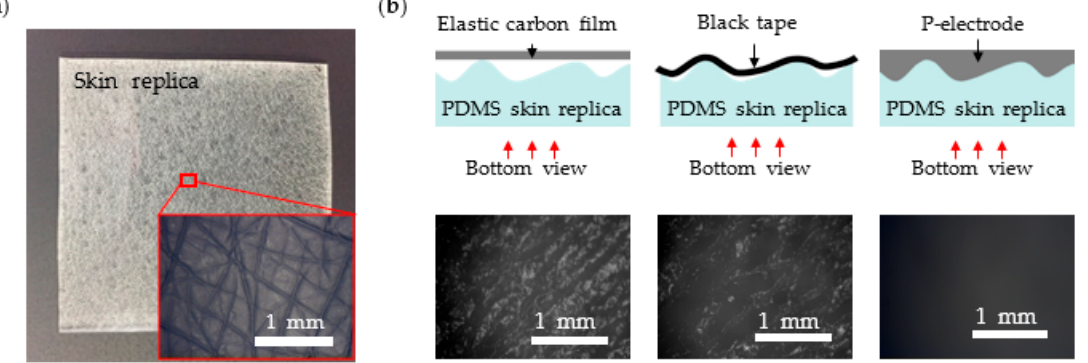
Figure 6. ( a ) PDMS skin replica and its microscopic structure; and ( b ) schematic cross-section views and microscopic pictures seen from the bottom surfaces for several contacts: flat P-electrode film, black tape, and P-electrode.